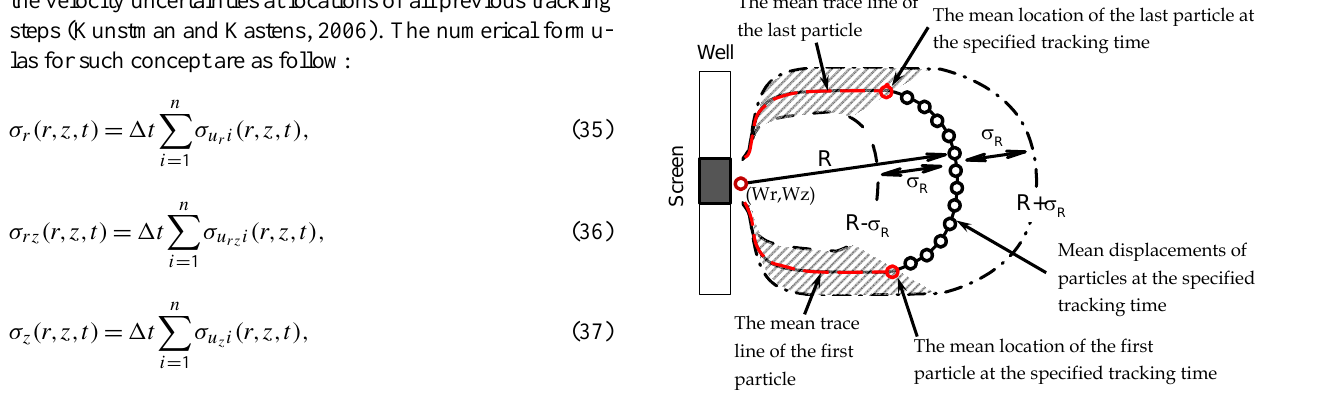
Fig. 1. The concept to calculate the bandwidths of a stochastic remediation zone.